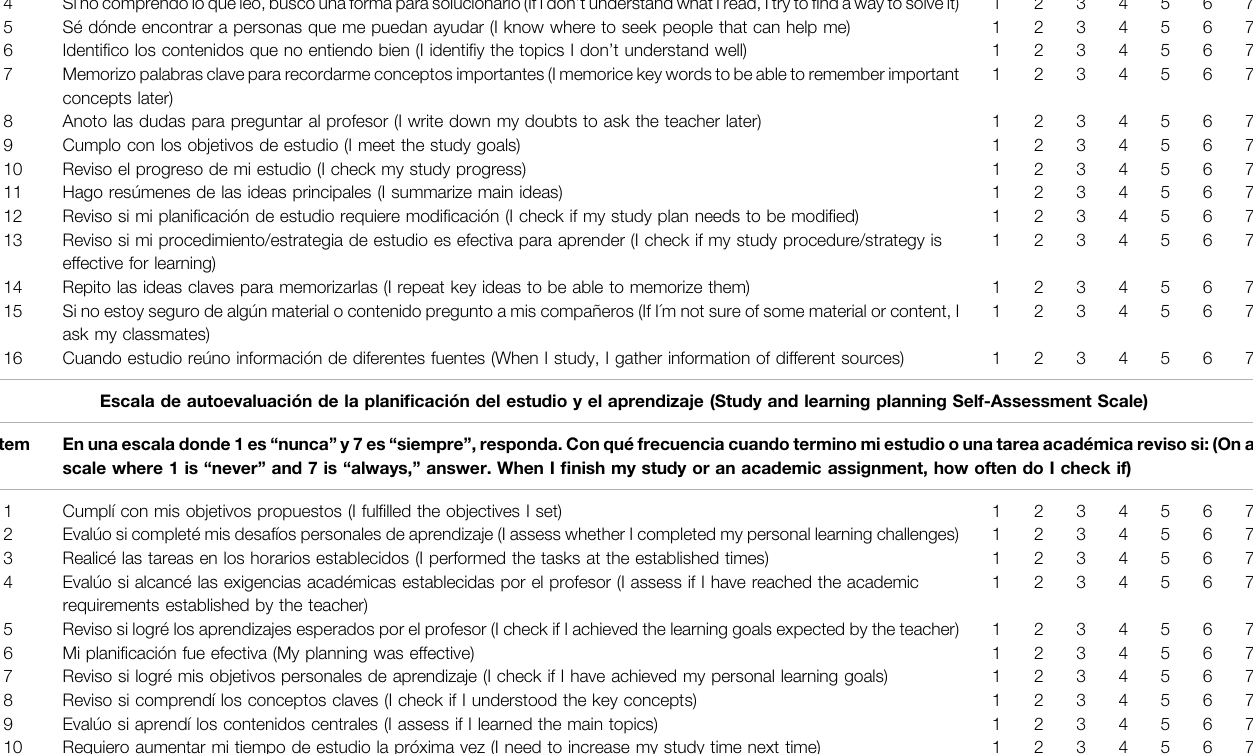
Memorizopalabrasclavepararecordarmeconceptosimportantes(Imemoricekeywordstobeabletorememberimportant concepts